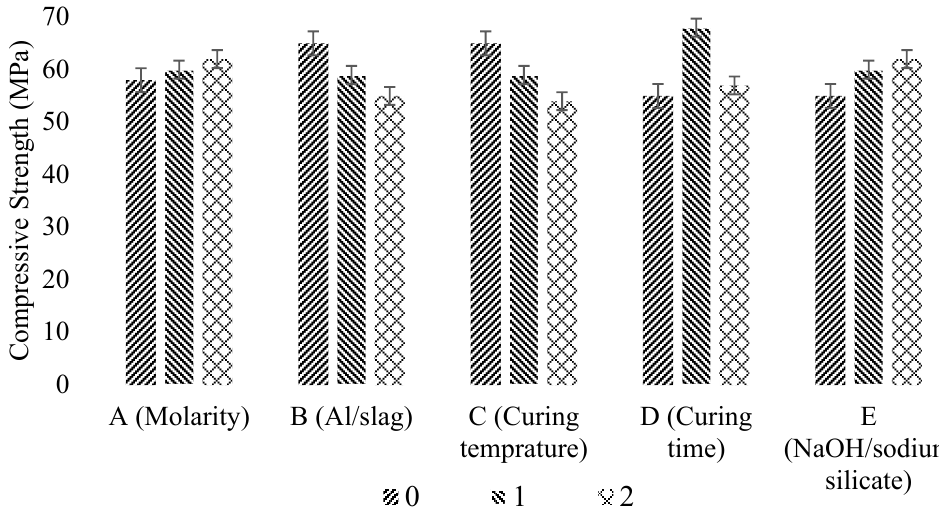
Figure 14. Factors affecting compressive strength after 28 days, modified from [2]; Elsevier, 2019.